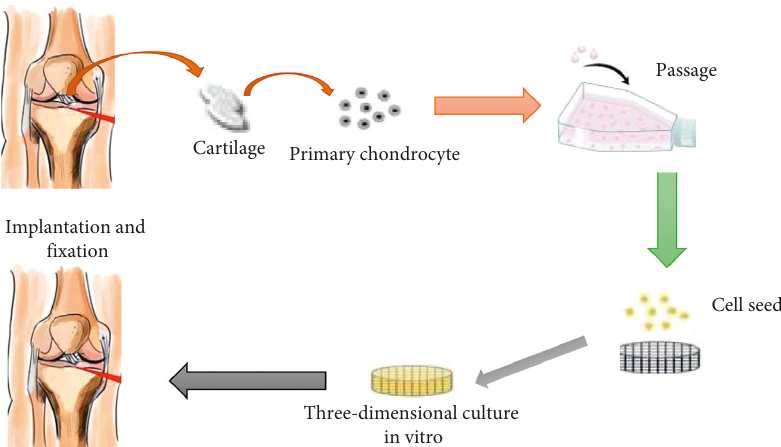
Figure 1: Schematic of cartilage tissue